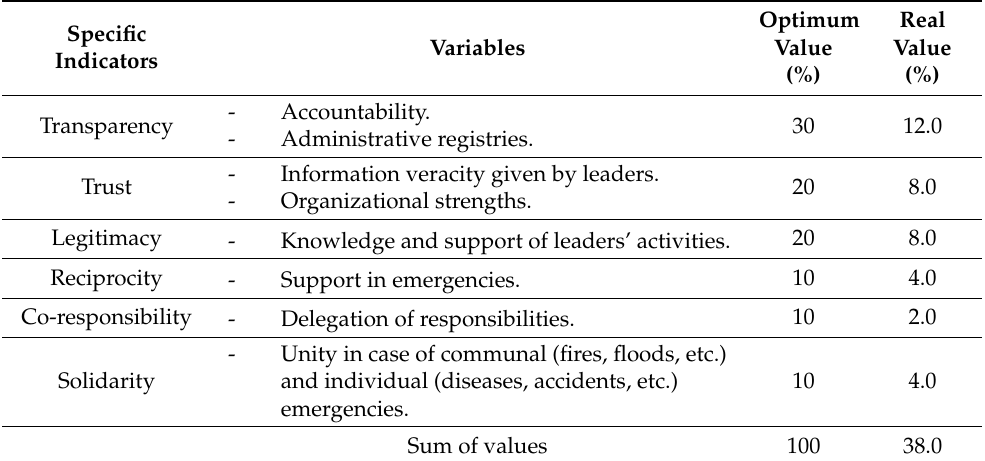
Table 7. Evaluation of specific indicators of social capital as part of community forest governance at San Miguel